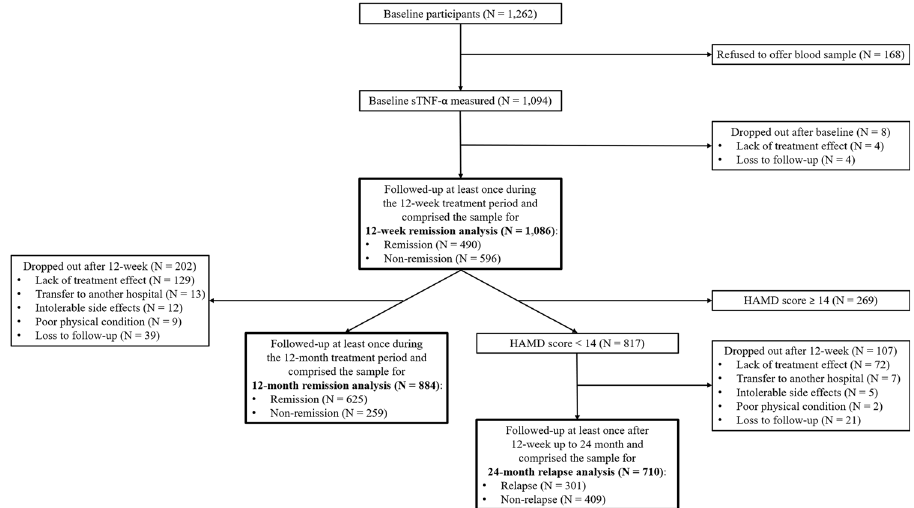
Fig. 1 Patient recruitment and fl ow. sTNF- α , serum tumor necrosis factor- α ; HAMD, Hamilton Depression Rating